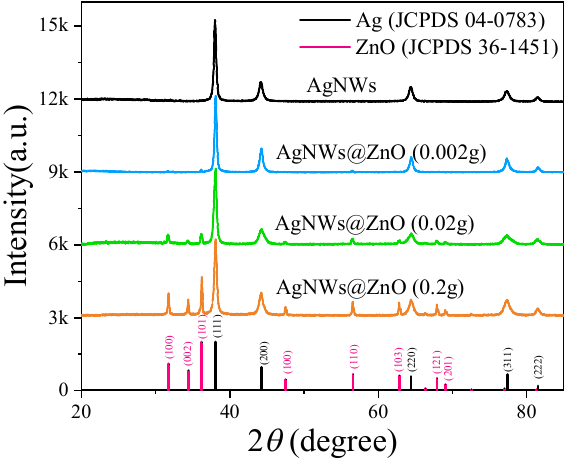
Figure 2. XRD patterns of Ag NWs and ZnO NPs@Ag NWs.